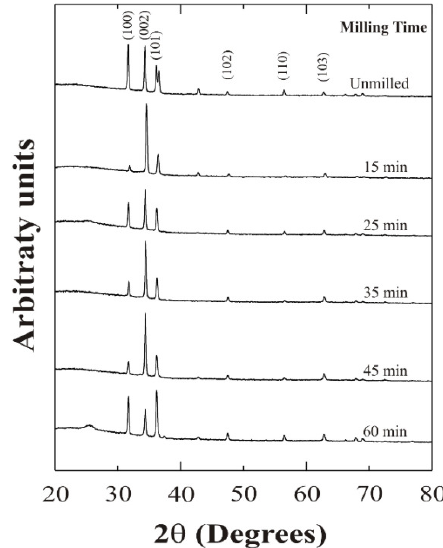
Figure 2. X-ray spectra of ZnO:Al thin films prepared from unmilled and milled Zn and Al